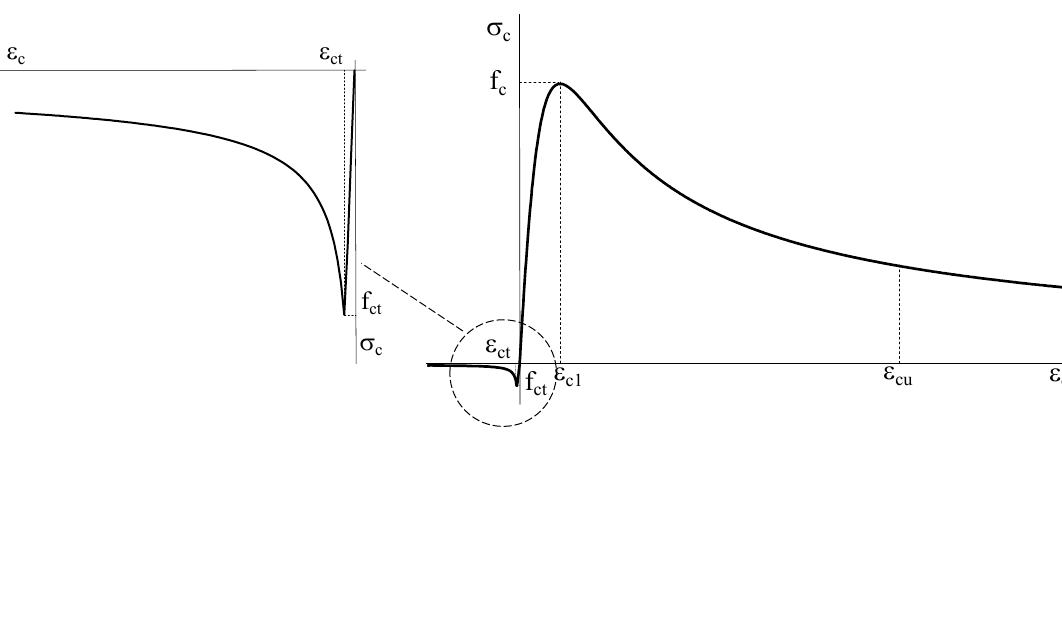
Figure 4. Stress-strain law for